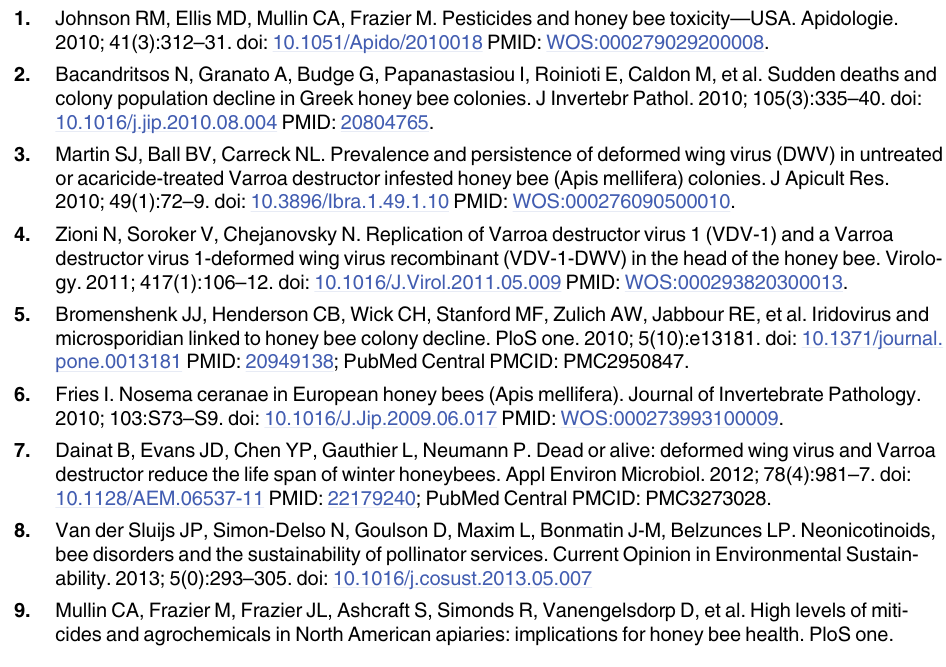
corn pollen Z . mays . S2 Fig. Correlation output. Linear mixed model output matrixes showing the different corre- lations between variables and the treatment